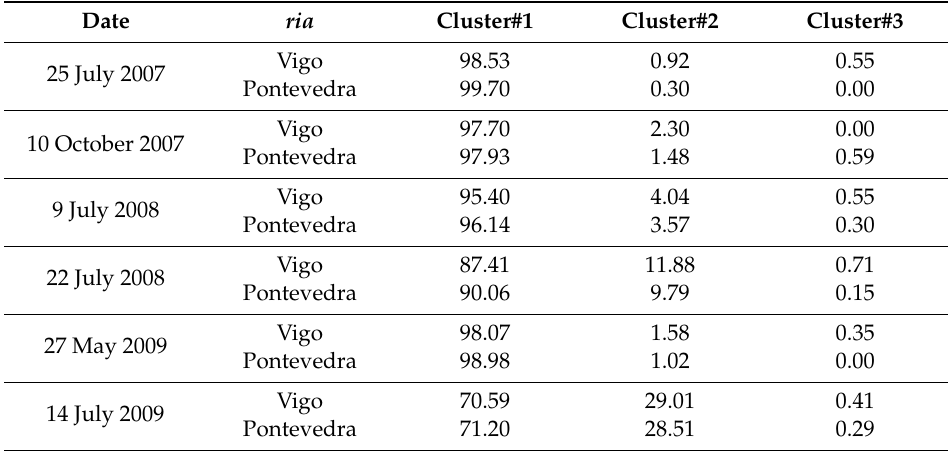
Table 4. Percentage of pixels belonging to each cluster over the study area, obtained from classification images derived from the MERIS images used in this study.